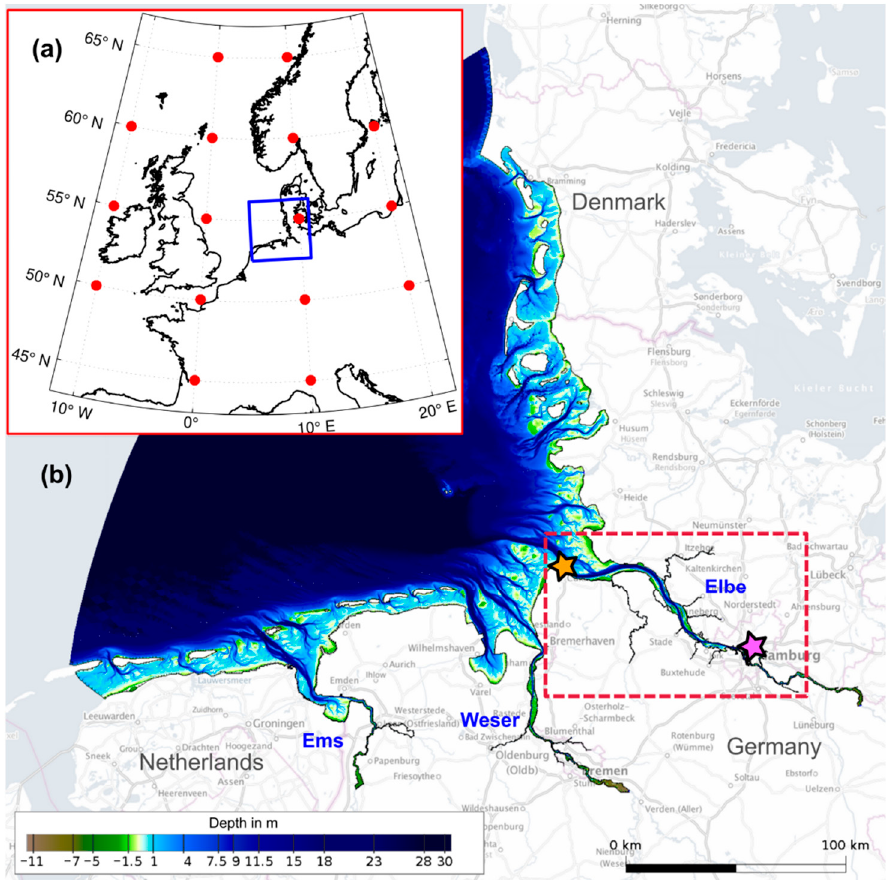
Figure 1. ( a ) Grid points (red dots) used to perform the LWT classification based on SLP data and domain of hydrodynamic modelling (blue rectangle); ( b ) Domain of the hydrodynamic-numerical model with depth information (m above mean sea level); the Elbe estuary is highlighted as red rectangle and the stations Cuxhaven and St. Pauli are marked with an orange and magenta star, respectively. The map in the background is provided by